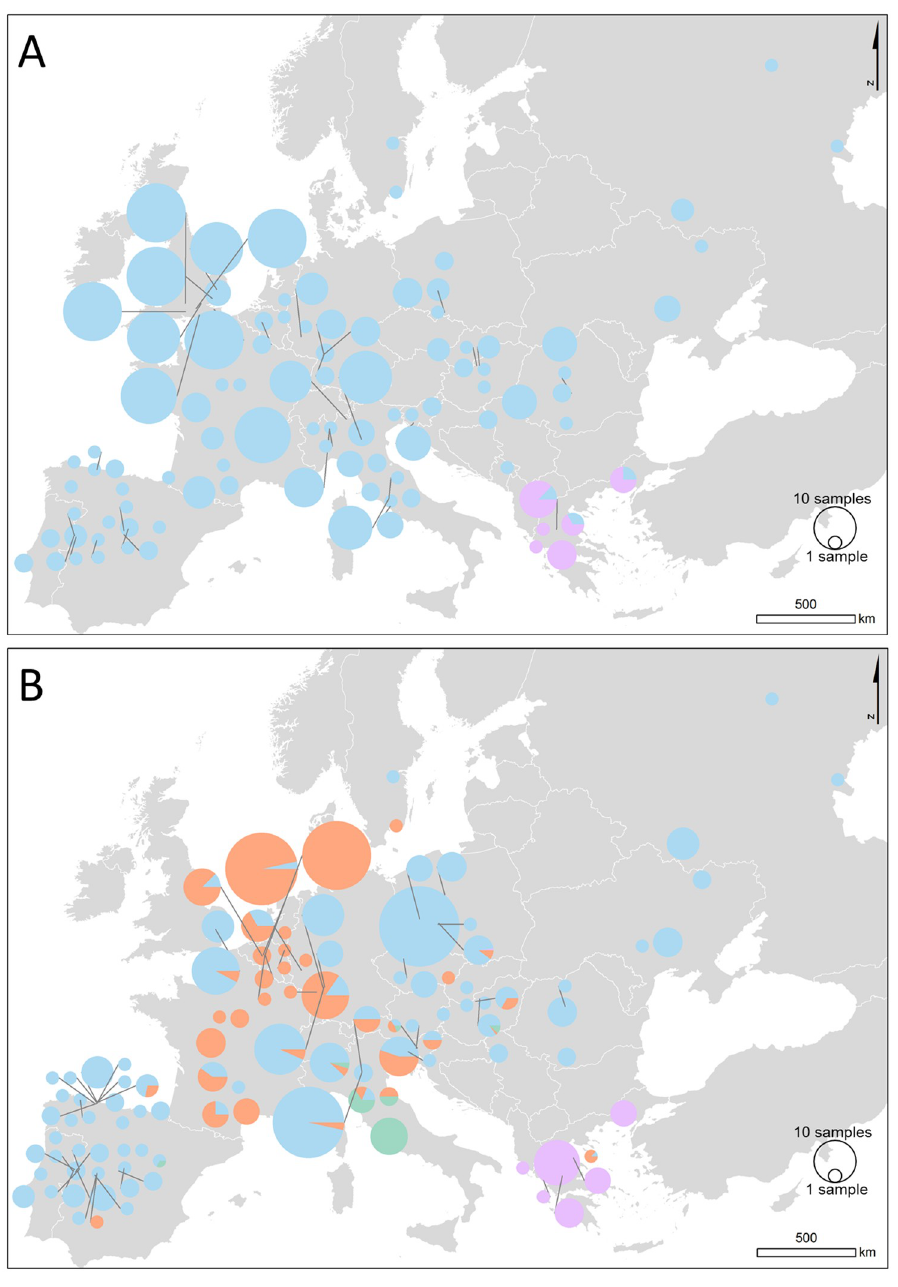
Fig 5. Bayesian cluster memberships obtained using BAPS for (A) the mtDNA dataset of Lucanus cervus and (B) the microsatellite genotypes. The pie charts represent the distribution of BAPS clusters, given in different colours, and are scaled according to sample